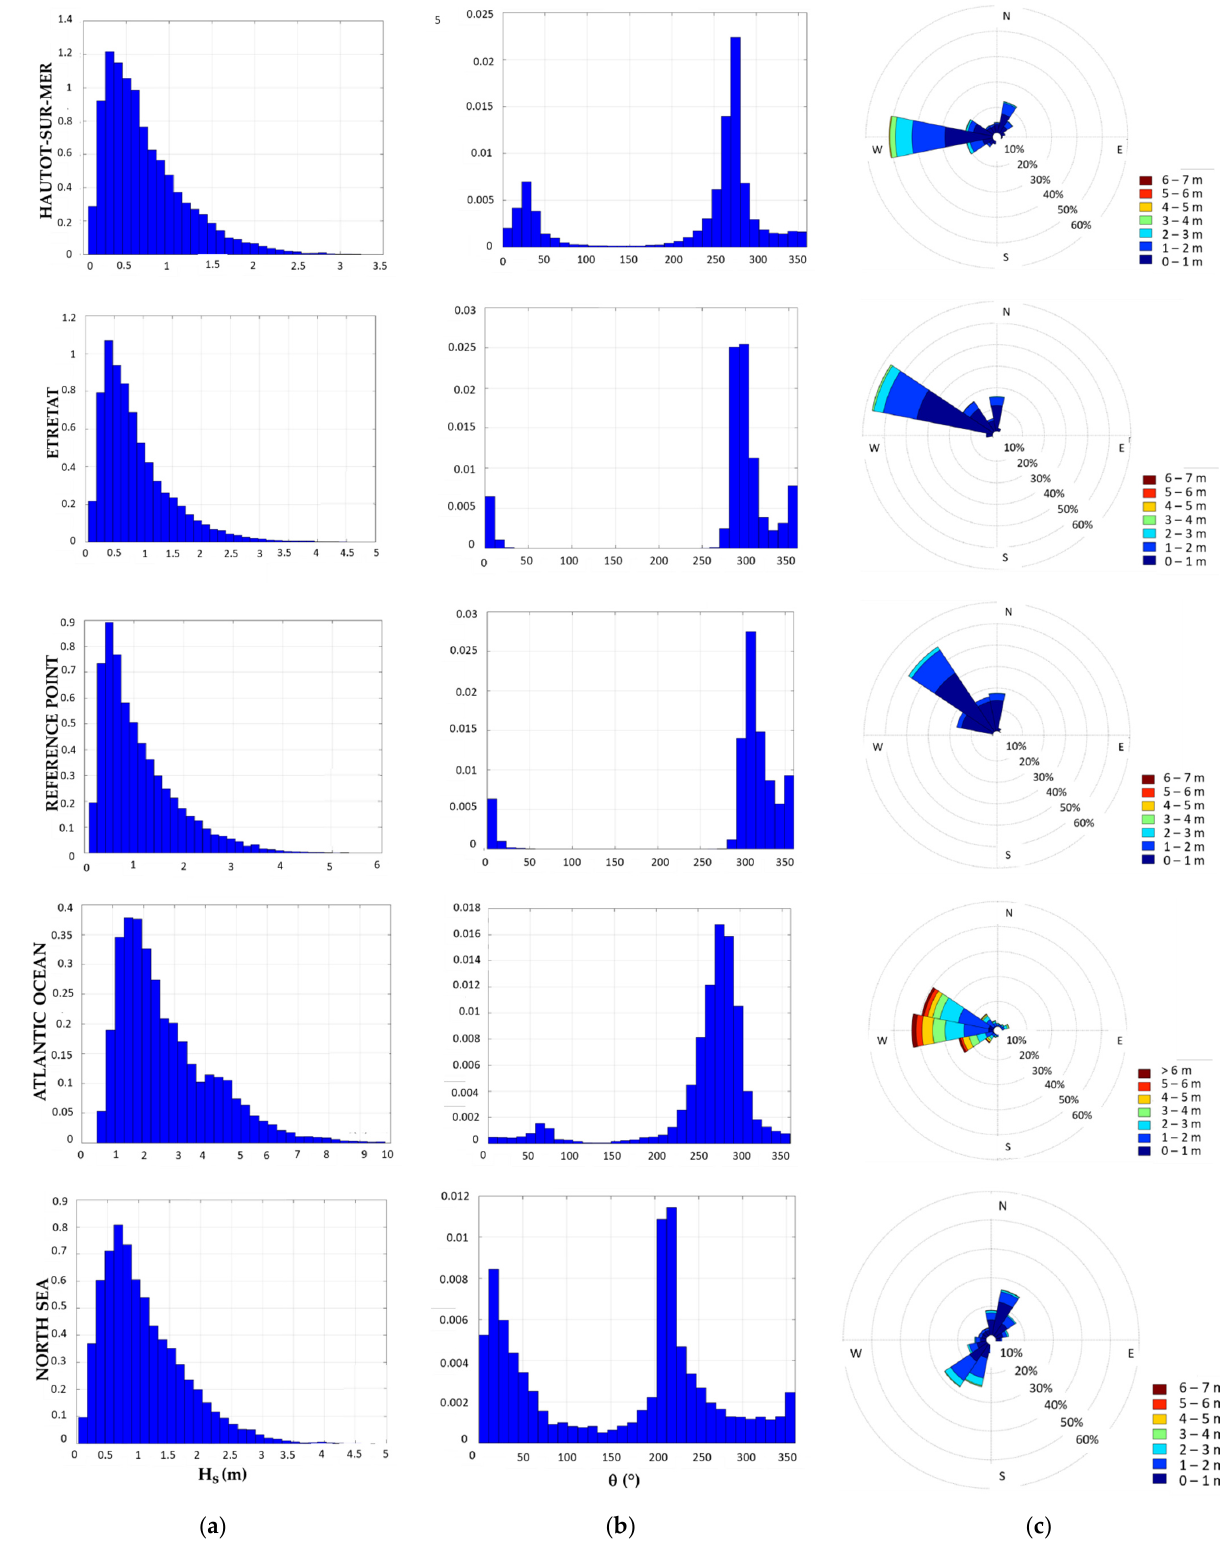
Figure 5. Probability Density Functions (PDF) of H s ( a ) and of θ ( b ) and wave roses ( c ) at deep waters in the North Sea (depth = 44 m), the Atlantic Ocean (depth = 116 m), the Reference point (depth = 28 m), close to Etretat (depth = 13.4 m) and to Hautot-sur-Mer (depth = 13 m).